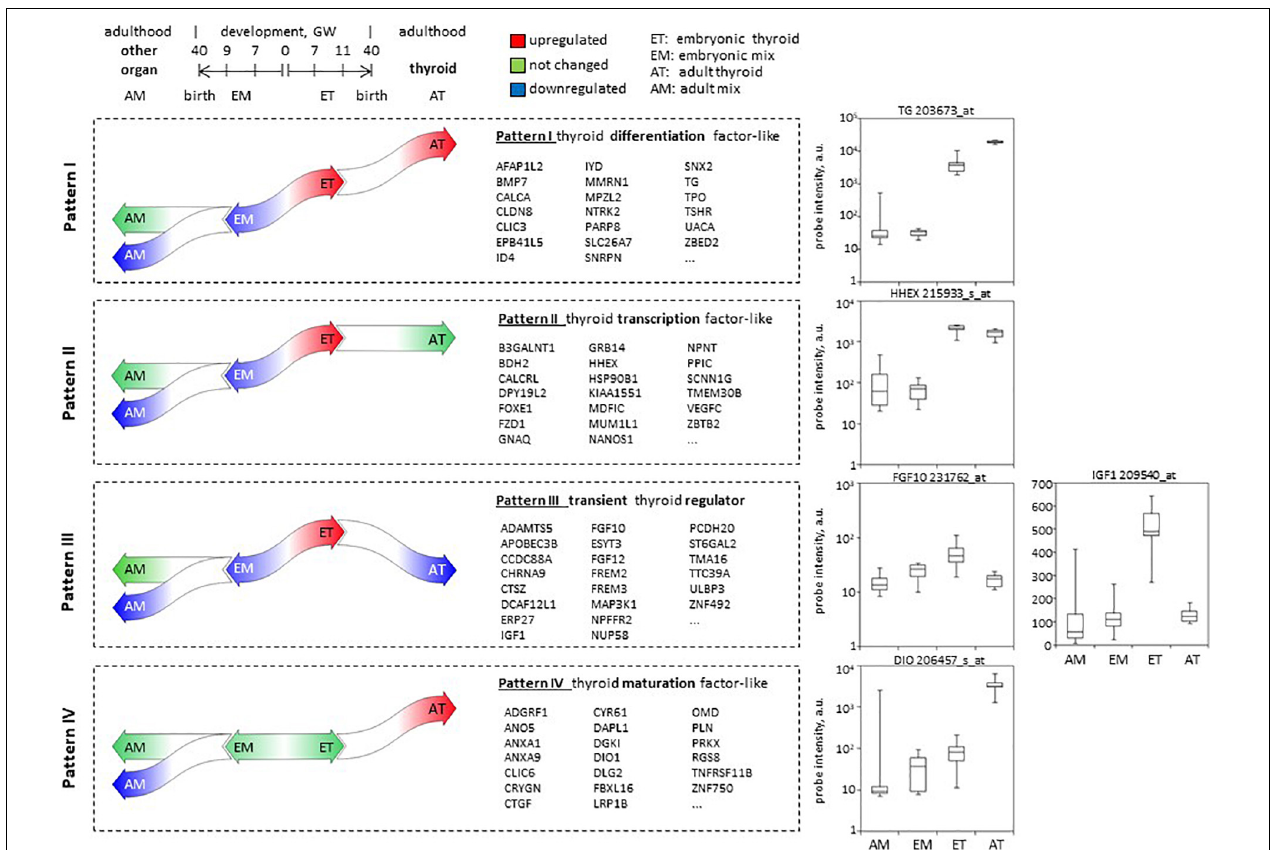
FIGURE 8 | Patterns of developmental gene expression in human thyroid. Schema of gene expression level changes in the course of development of the thyroid and other organs, defining patterns I–IV of expression. In the middle: lists of top 20 protein-coding genes corresponding to each pattern. Complete lists can be found in Supplementary Table 3 . To the right: boxplots illustrating hybridization intensity of microarray probes corresponding to one gene representative of each pattern of